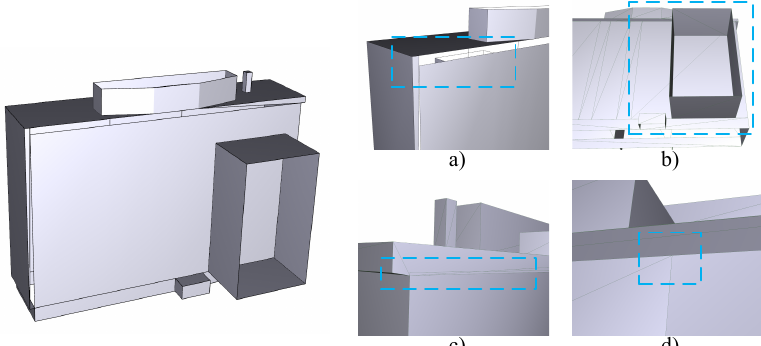
Figure 1. Demonstration of errors in a 3D building model (a) a gap on the façade of the left model; b) intersections between building parts in the left model; c) a non-manifold edge shared by multiple faces; d) a T-junction caused by a degenerated